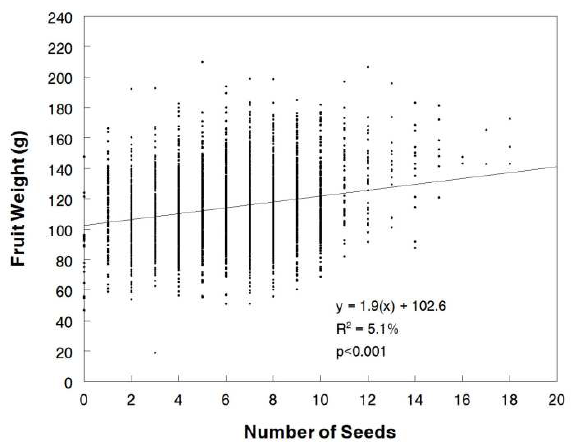
F IGURE 7. Apple fruit weight (grams) versus the number of seeds per